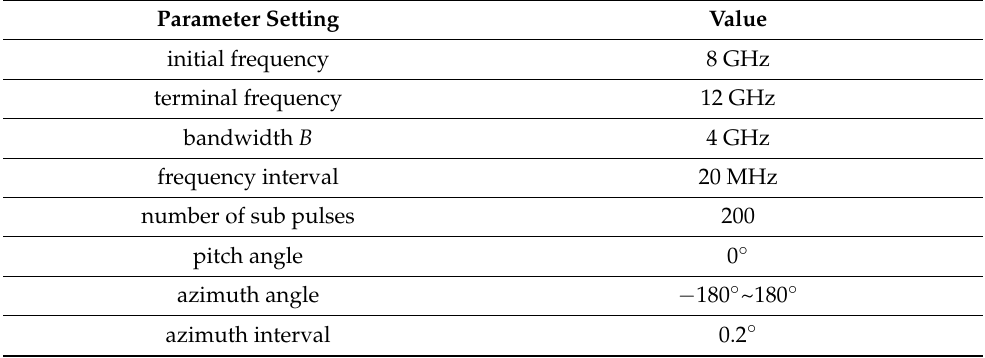
Table 4. Parameters of sweep signal.